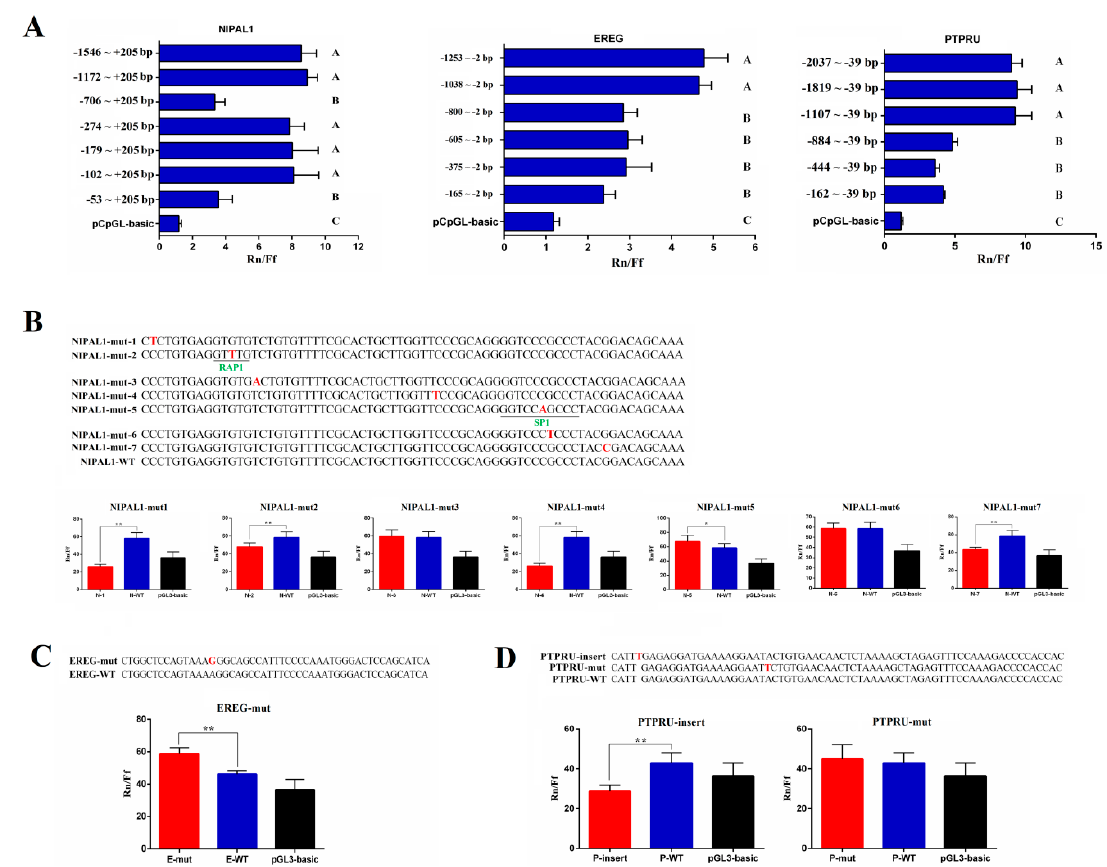
Figure 7. Identification of the core promoter regions of miR-215 target genes and the effects of SNPs on promoter activities. ( A ) Dual luciferase activity in different segments of promoters of the miR-215 target genes NIPAL1 , EREG and PTPRU genes. ( B to D ) Wild type and mutant sequences of NIPAL1 , EREG and PTPRU genes core promoters and their effects on promoter activities. Red letters represent mutation sites, green letters and underlines represent transcription factors and their binding sites.